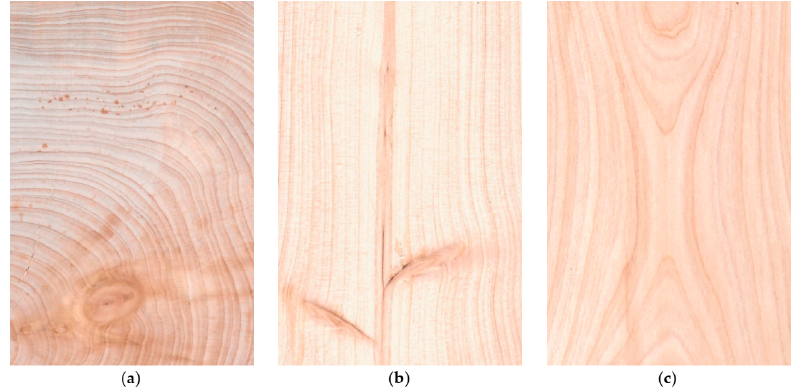
Figure 2. Macroscopic images of oriental arborvitae: ( a ) transverse, ( b ) radial, and ( c ) tangential